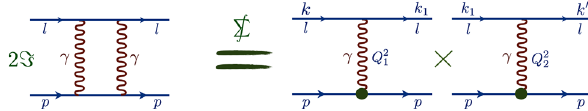
Fig. 3 Unitarity relations for the case of the elastic intermediate state contribution